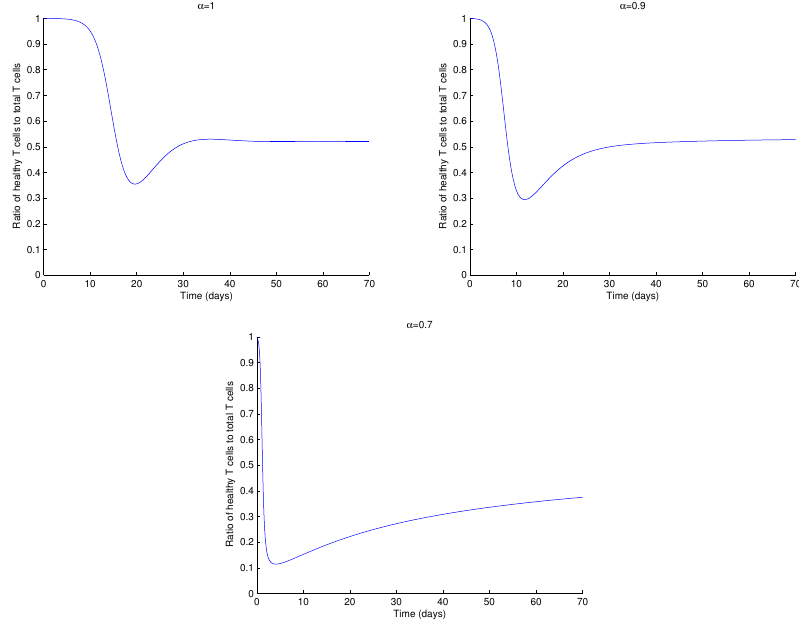
Figure 2. Ratio of healthy CD4 + T cells, T , to total CD4 + T cells, T + L + I , of system (1) without PEP for α = 1 ( top left ), α = 0.9 ( top right ) and α = 0.7 ( bottom ). Parameter values and initial conditions in the